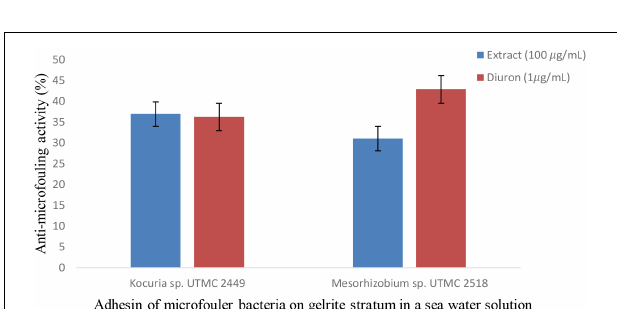
FIGURE 5 | The effect of extract on the viability of Kocuria sp. UTMC 2449 and Mesorhizobium sp. UTMC 2518 cells in biofilm state. The lethal activity of the Glycomyces sp. UTMC 2460 metabolite at the lowest biofilm inhibition concentration (100 µ g ml − 1 ) was resembeled to ciprofloxacin as the control compound with bactericidal activity.